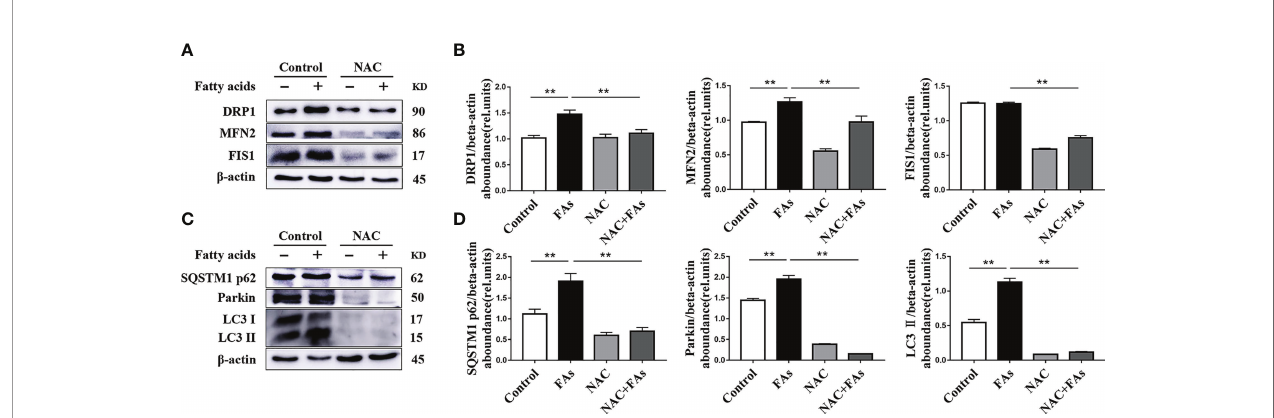
FIGURE 11 | ROS levels affect the expression of mitochondrial dynamics-related protein and autophagy-related protein. CD4 + T cells were sorted from spleens from 1-d old calves and stimulated with NAC (10 mM) before FAs treatment with 12 h (A) Western blot analysis of mitochondrial dynamics-related protein in CD4 + T cells (n = 4 per group). (B) Relative abundance of mitochondrial dynamics-related protein (n = 4 per group). (C) Western blot analysis of autophagy-related protein in CD4 + T cells (n = 4 per group). (D) Relative abundance of autophagy-related protein (n = 4 per group). The data of the control were used to normalize other treatments. Comparisons among groups were calculated using a one-way ANOVA with a Duncan correction. The data presented are the mean ± SEM, **P ≤ 0.01 indicate differences from control or NAC